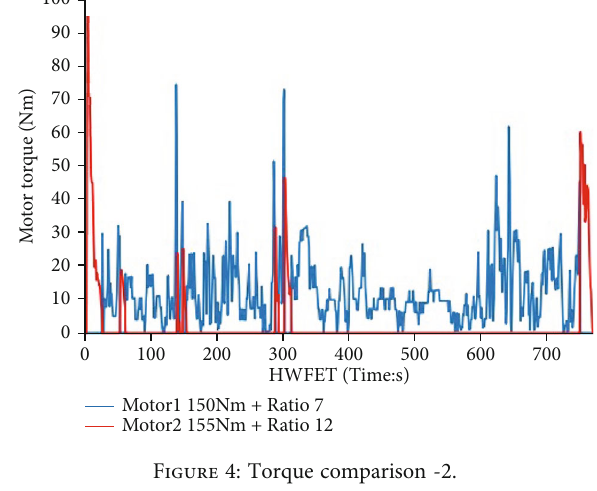
Figure 3: Torque comparison – 1.